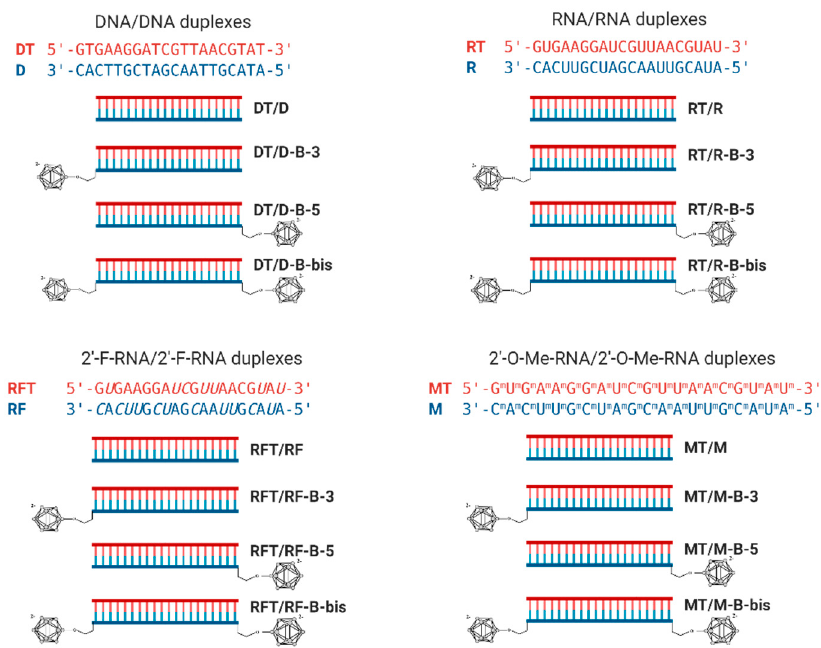
Figure 4. Complementary complexes of oligonucleotides bearing of closo -dodecaborate at 5 ′ - Int. J. Mol. Sci. 2021 , 22 , x FOR PEER REVIEW 3 (cid:48) -terminus of one of the components. and/or 3 ′ -terminus of one of the components.